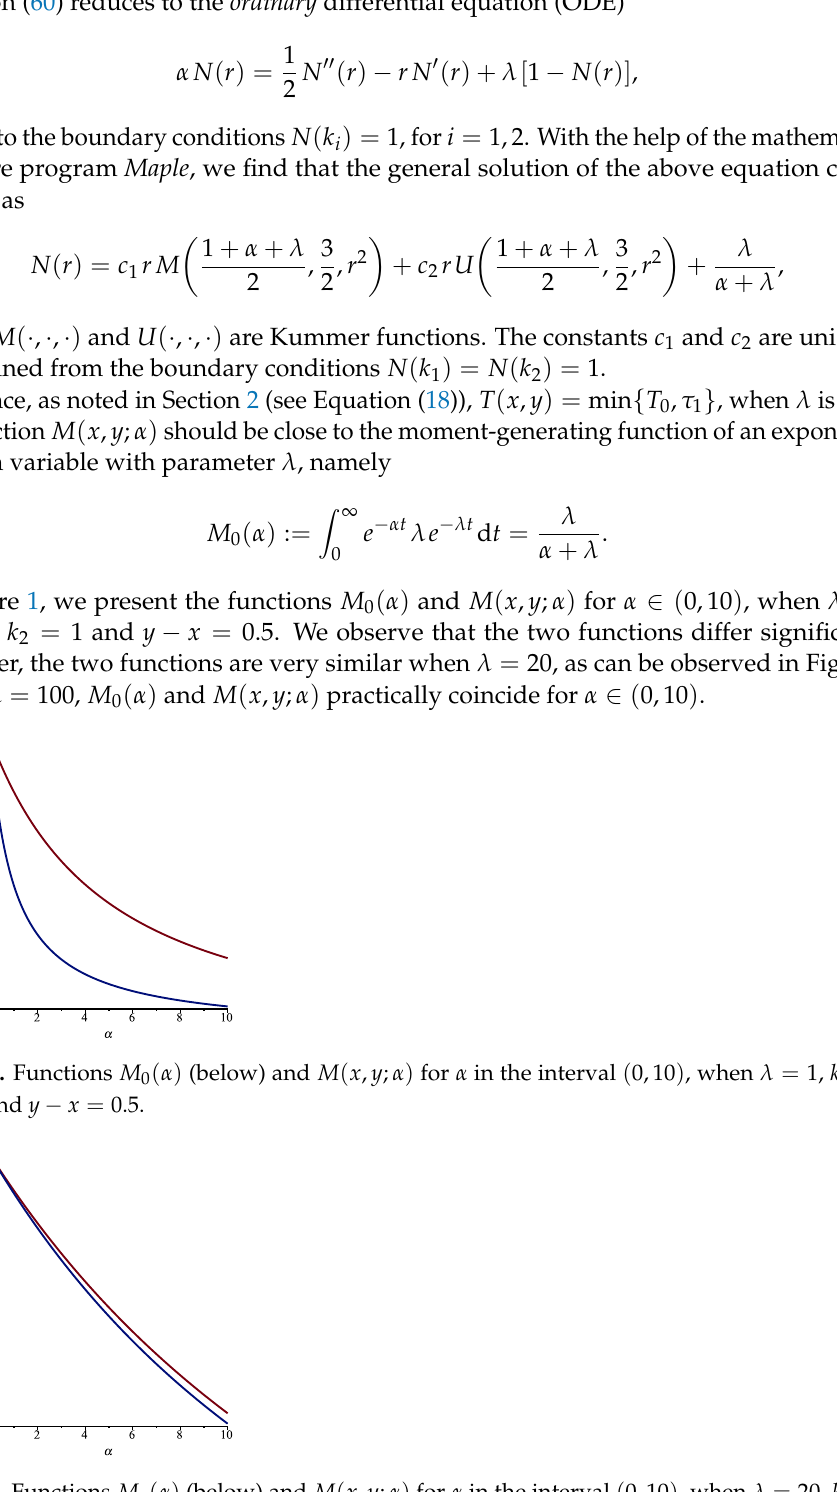
Figure 2. Functions M 0 ( α ) (below) and M ( x , y ; α ) for α in the interval ( 0,10 ) , when λ = 20, k 1 = 0, k 2 = 1 and y − x =